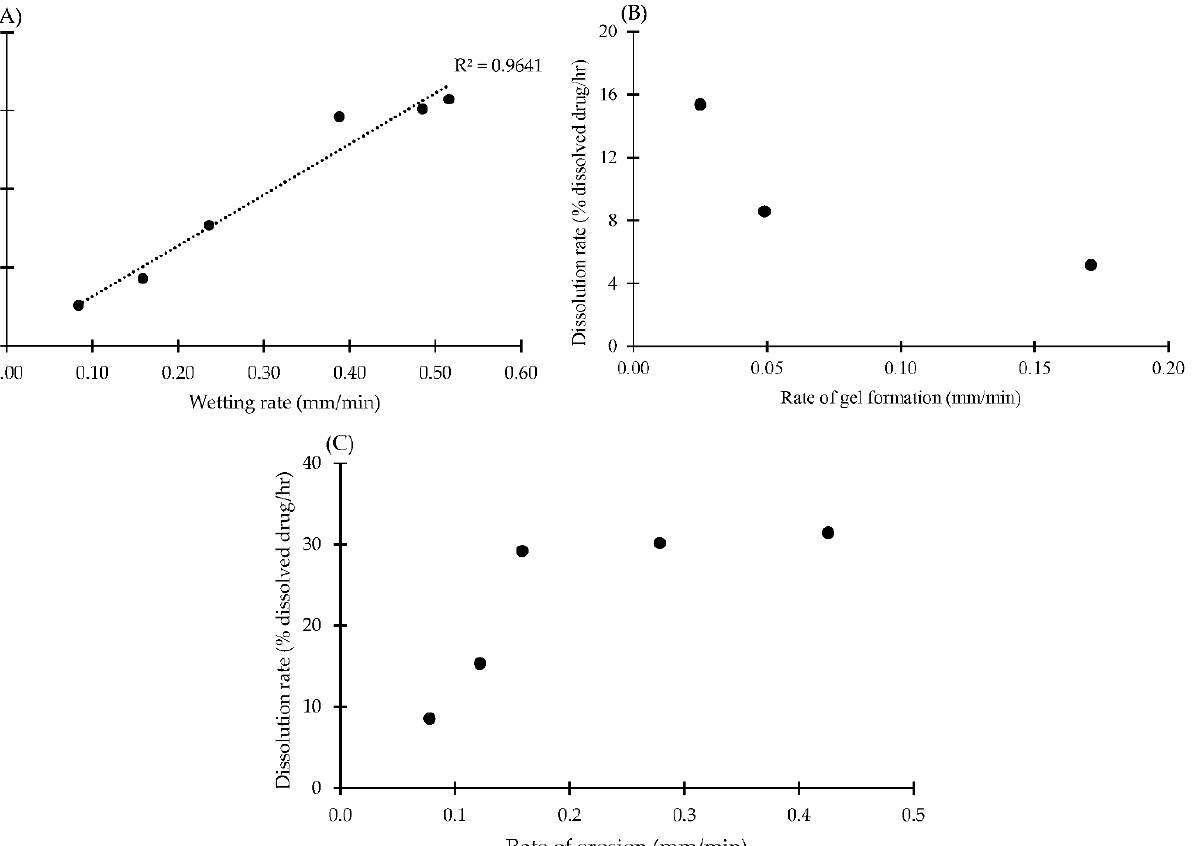
Figure 9. Correlation between rate of wetting ( A ), gel formation ( B ) and erosion ( C ) with disintegra- tion time of eutectic effervescent tablets in 0.1 N HCl buffer pH 1.2.